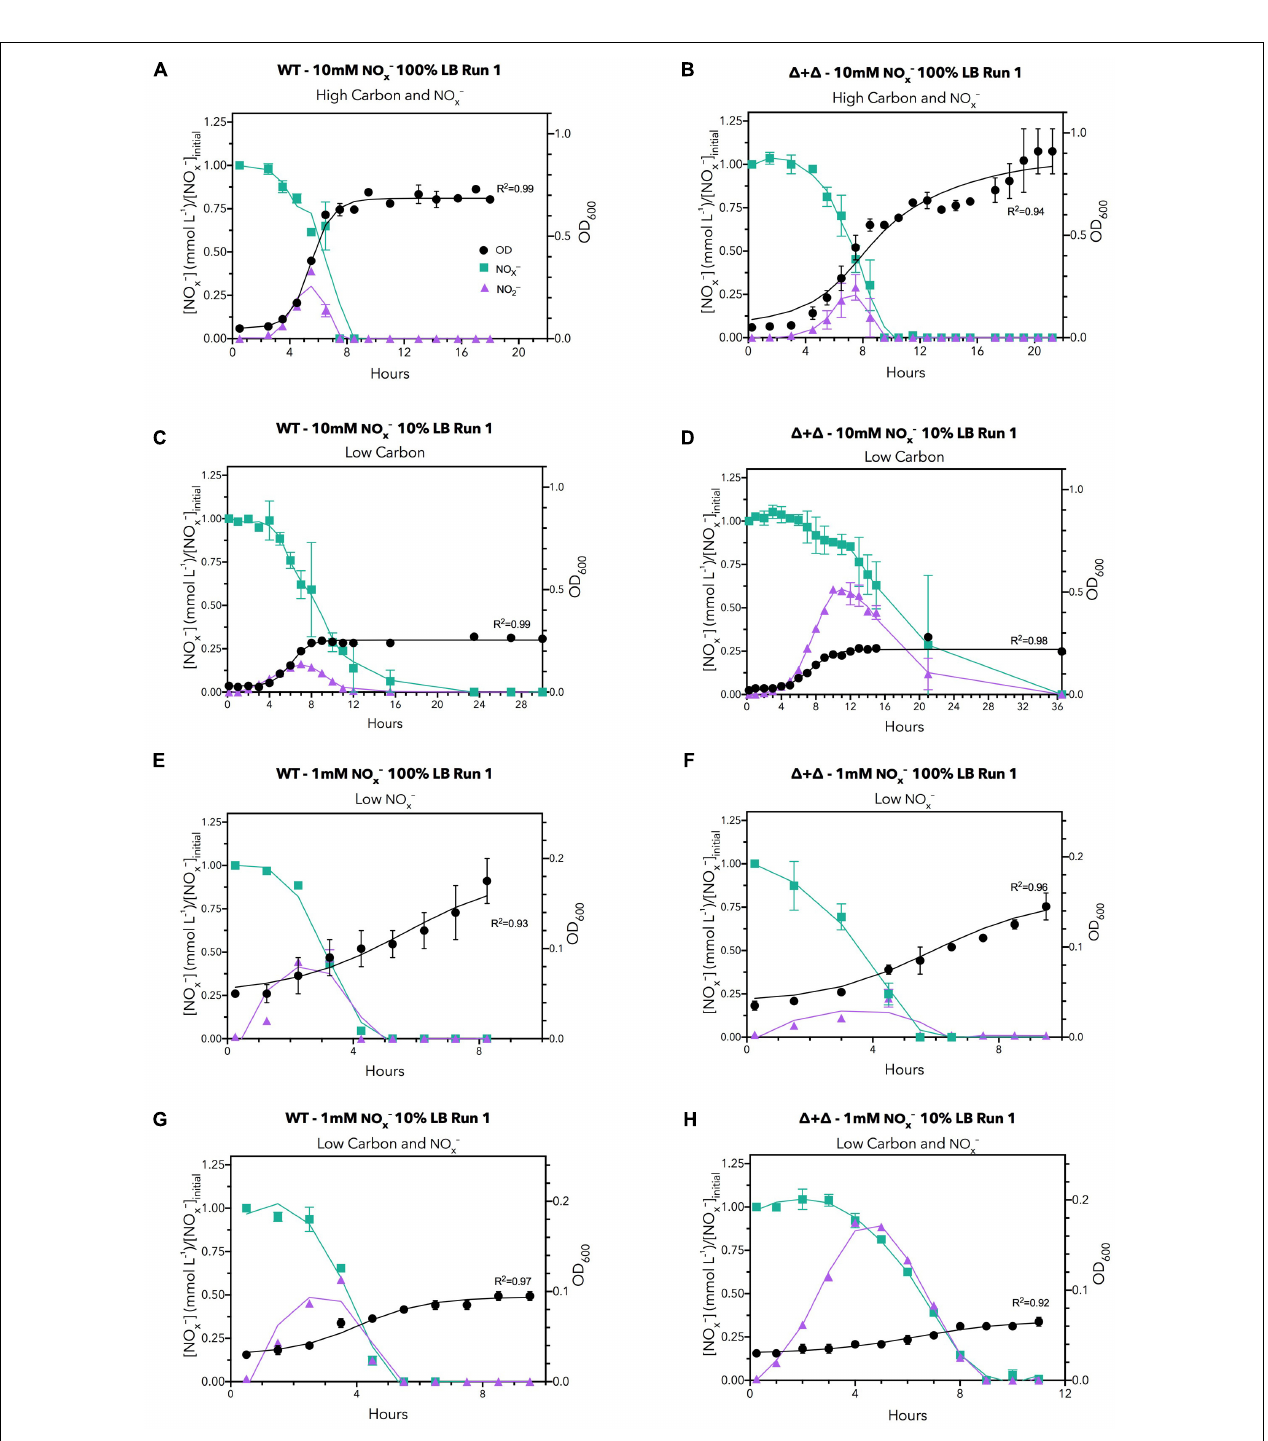
FIGURE 2 | Time series data under all LB nutrient regimes for 10:0 NO 3 − /NO 2 − ratios for the first run. The regimes are: (A,B) high carbon and NO x − (C,D) low carbon, (E,F) low NO x − and (G,H) low carbon, and NO x − . NO x − (green), NO 2 − (purple), and bacterial growth (black) are shown. Left hand panels correspond to the wild-type culture whereas right hand panels depict the mutant co-culture. NO x − data are normalized to the initial NO x − concentration during plotting to reduce variability introduced by chemiluminescent measurements and variations in initial NO x − loading. Data points are the means of two biological replicates per condition, with error bars indicating ranges. Curves for NO x − and NO 2 − were smoothed with a Savitsky-Golay filter, while OD 600 curves were fit to a logistic growth model. Selected plots are presented for brevity; analogous plots for other replicates and initial NO 3 − /NO 2 − ratios can be found in Supplementary Figures 6–9 .